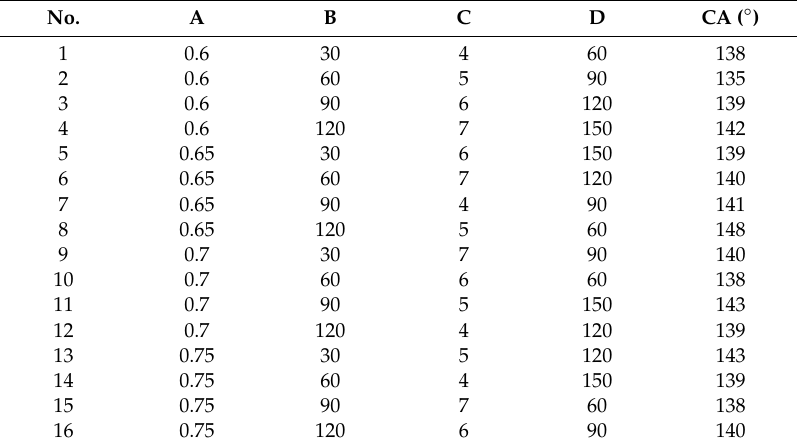
Table 3. Design of the orthogonal test and experimental